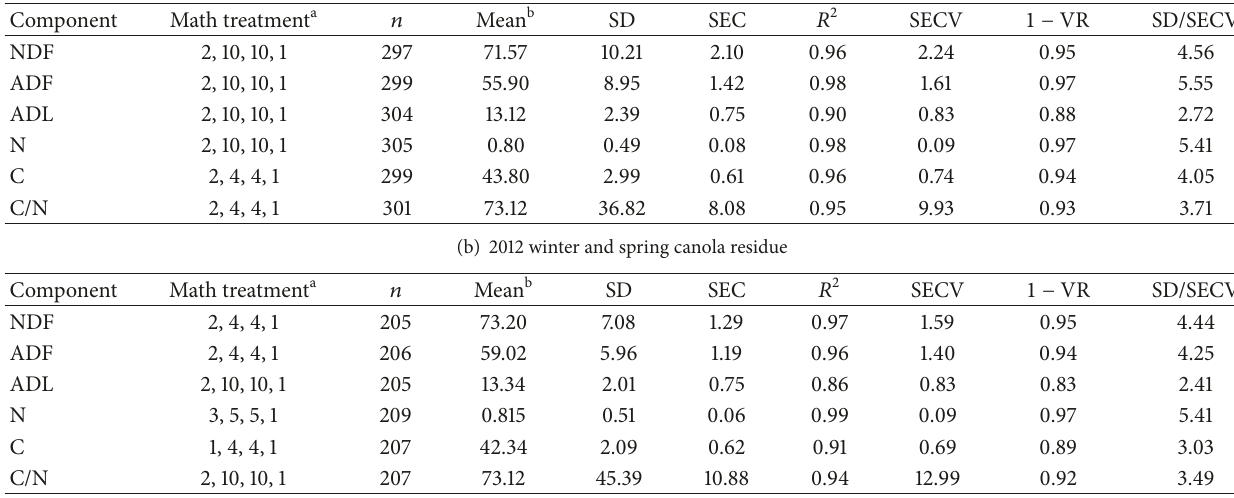
Table 1: Calibration statistics for prediction of NDF, ADF, ADL, N, C, and C/N in 2011 and 2012 winter and spring canola residue using NIRS. Residue consisted of stems, litter (small stems, leaves, and pods), and roots.